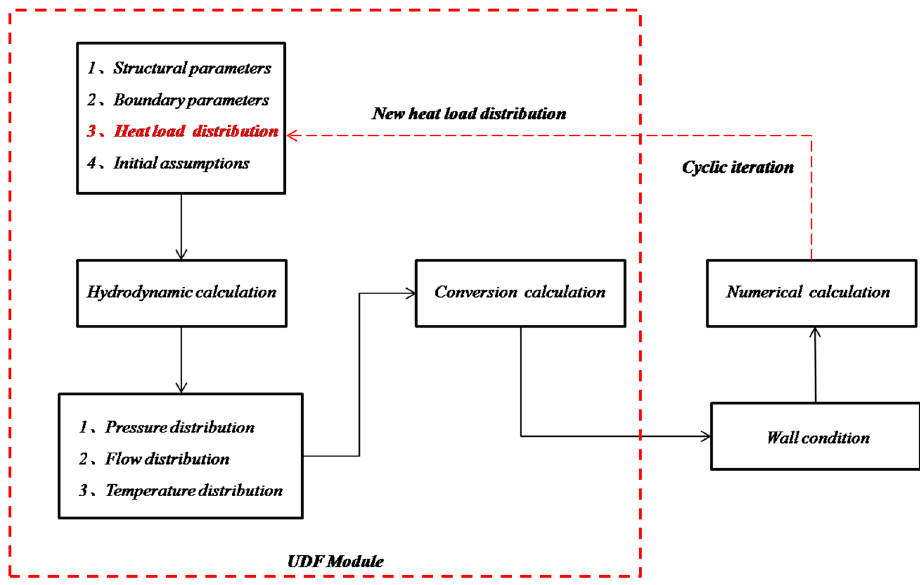
Figure 4. Schematic of UDF coupling technology.